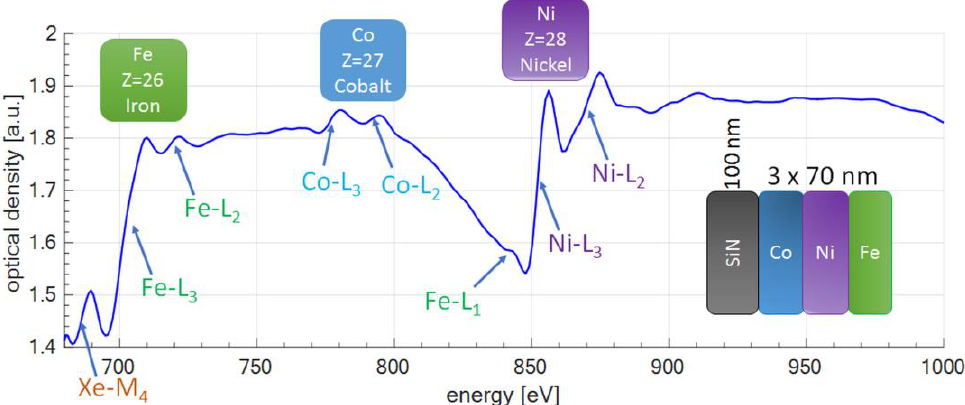
Figure 7. The wide-band spectral optical density of a Fe-Co-Ni multilayer sample (each layer ~70 nm in thickness), total sample thickness ~216 nm. The figure shows identifiable L absorption edges of all three sample constituents.